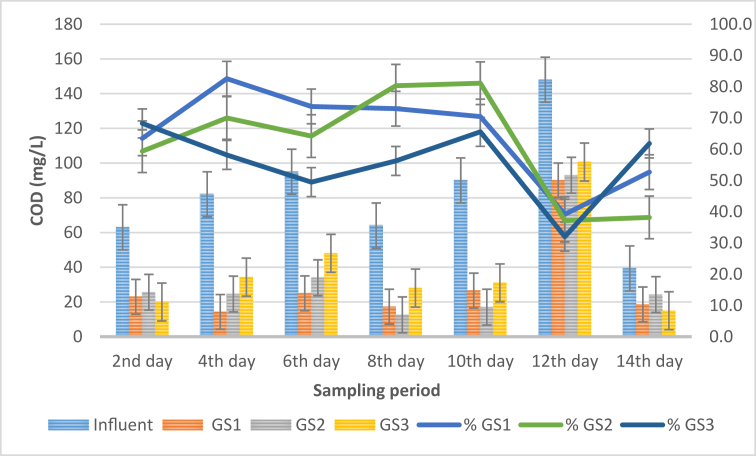
COD concentration against sampling period.